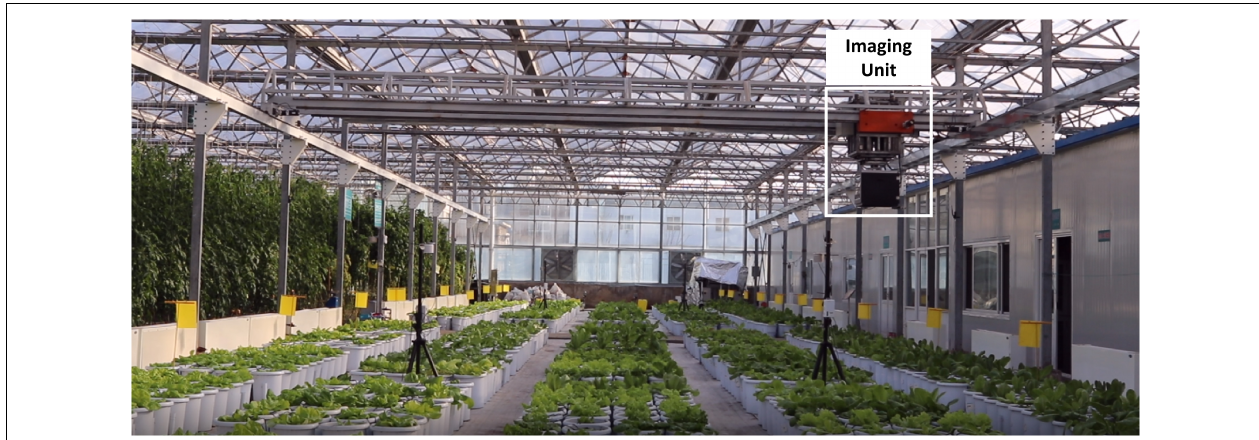
FIGURE 1 | High-throughput phenotyping platform for greenhouses. The imaging unit is driven along a route with planned according to x and y coordinates, and top-view images of lettuce plants are captured according to a timer or its position.